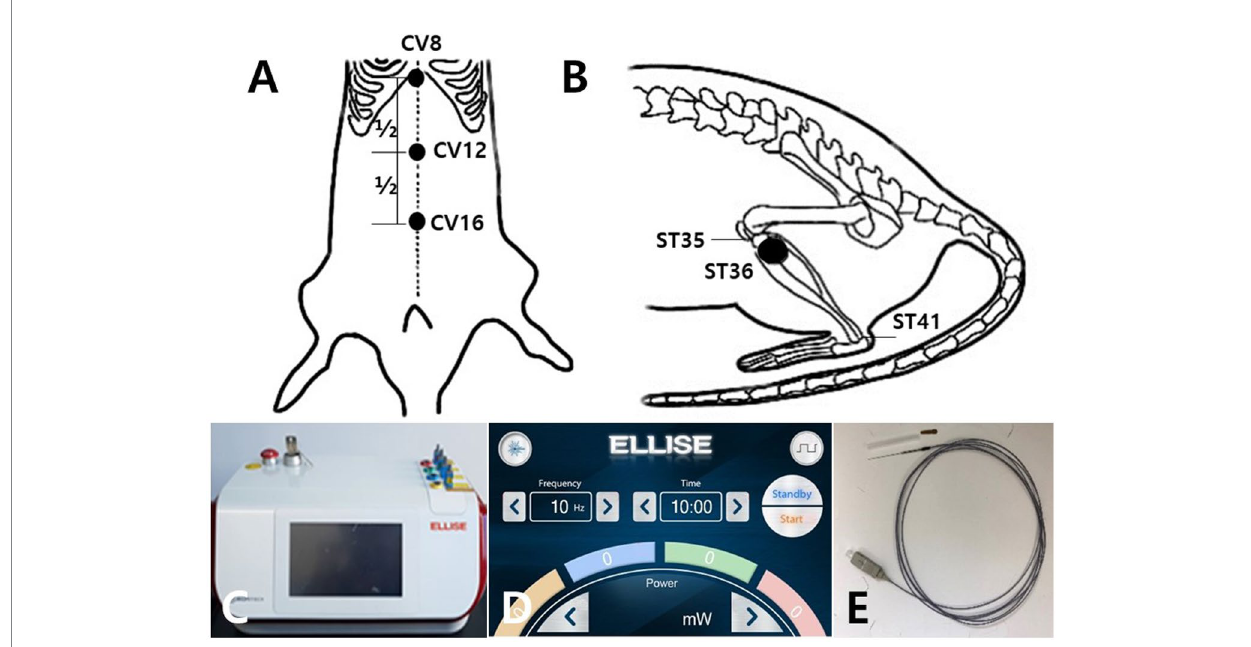
FIGURE 1 Schematic diagram of acupoints CV12 and ST36 and the laser and electrical stimulator System. Schematics show the acupuncture points CV12 (A) and ST36 (B) . CV12 was located at the median point of the abdominal midline connecting the umbilicus and sternum (A) . ST36 was located in the tibialis anterior muscle (B) . The laser and electrical stimulator system (ELLEISE, WONTECH Co., Ltd., Republic of Korea) used for laser acupuncture and electrical stimulation is shown, including the main body of the system (C) , the laser output adjustment screen (D) , and the fiber-optic acupuncture cable (E)